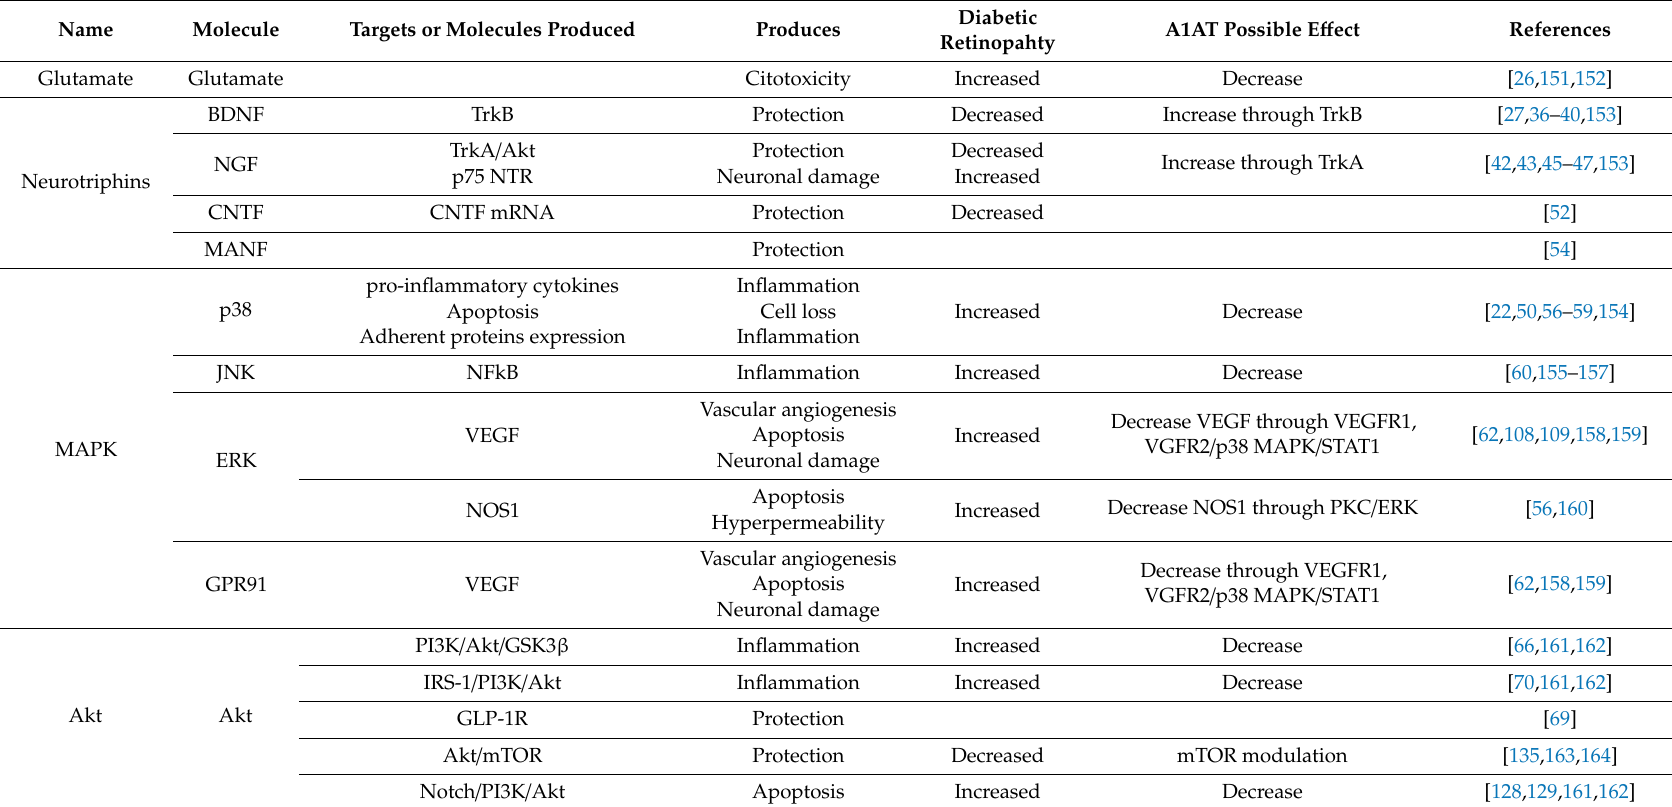
Table 1. Mechanisms involved in RGC loss in diabetic retinopathy and A1AT possible